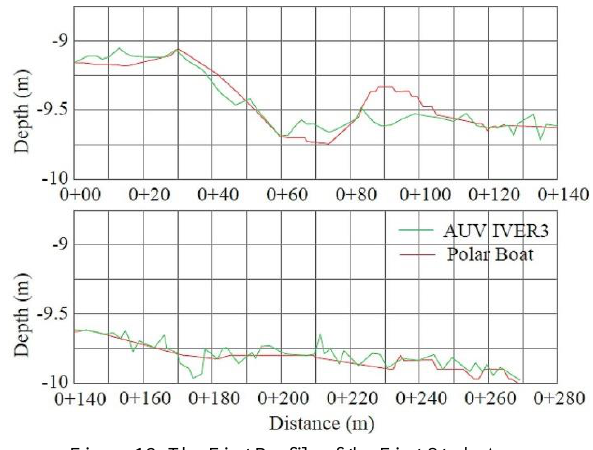
Figure 12. The First Profile of the First Study Area